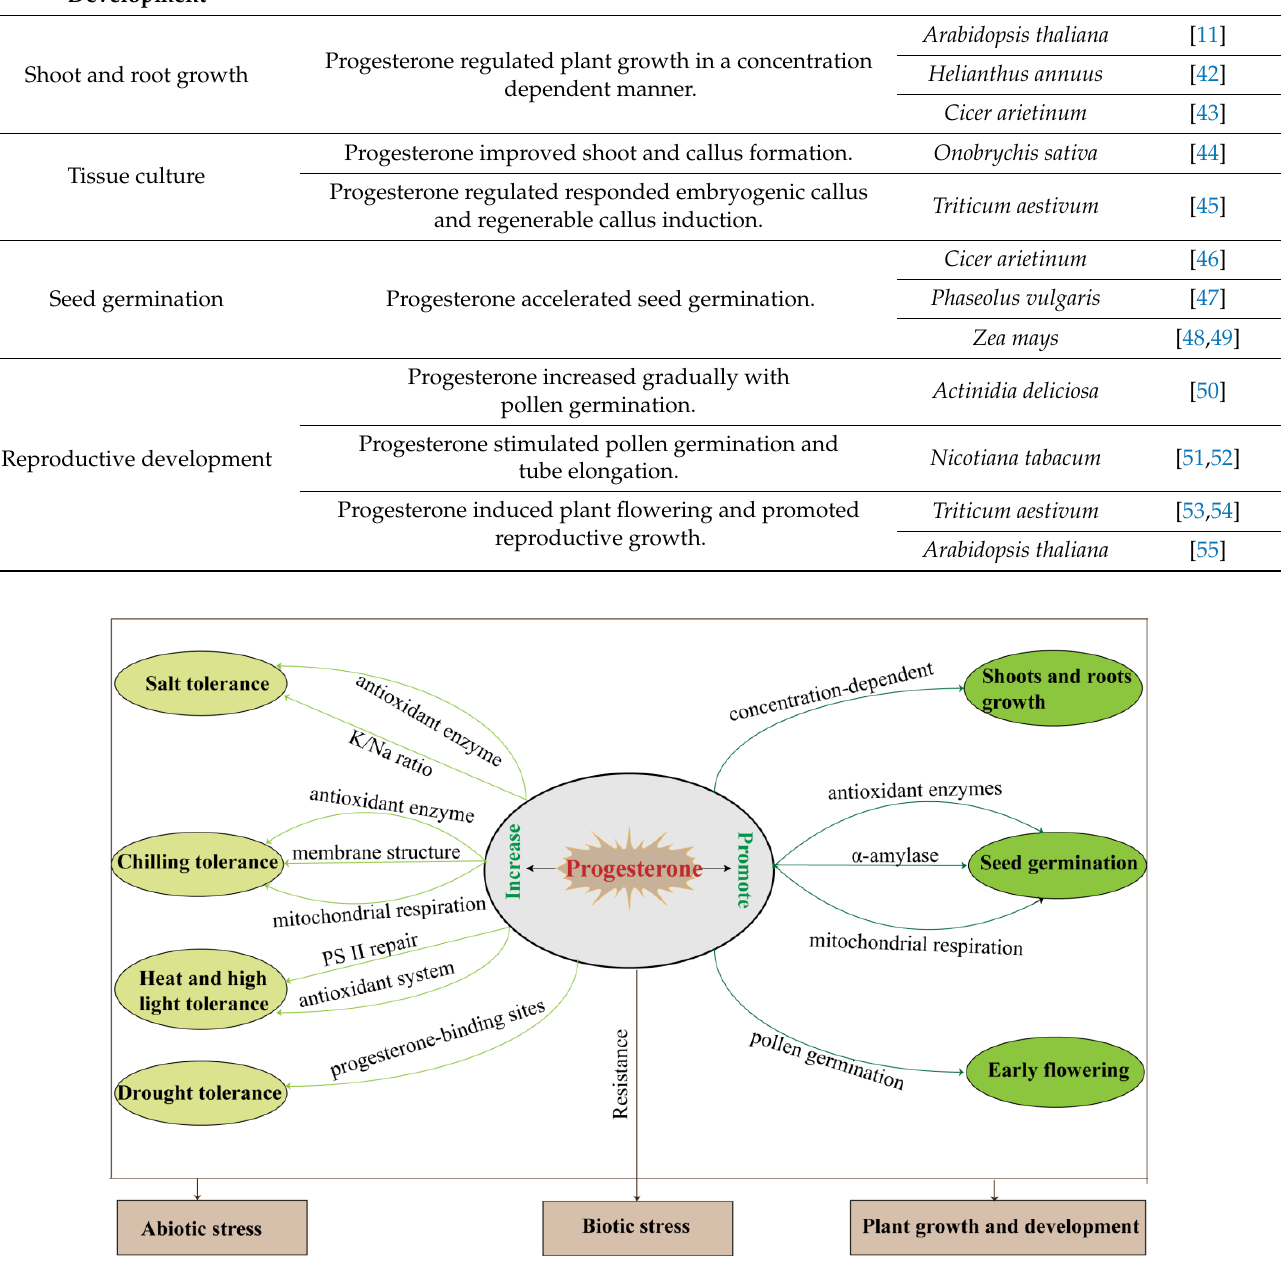
Figure 3. The summary of plant progesterone regulation during growth, development, and biotic/abiotic stress responses.